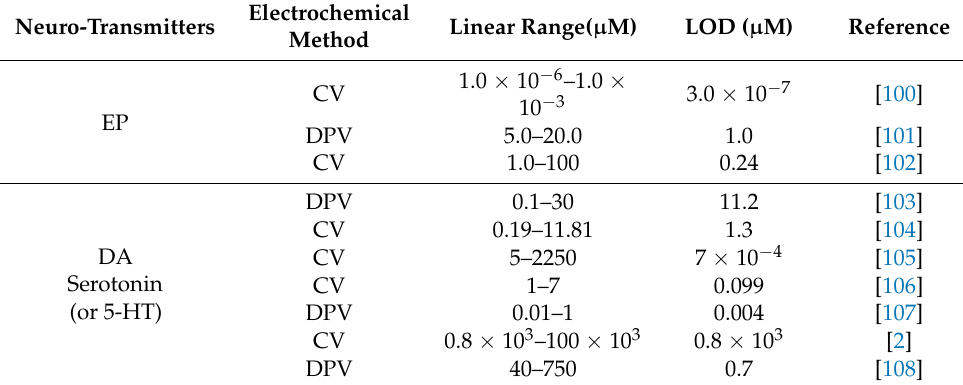
Table 2. A list of CDs-based sensing platforms in the detection of